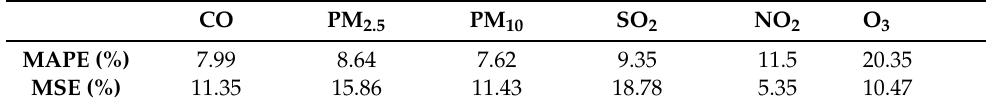
Table 2. Prediction results in cooperative monitoring